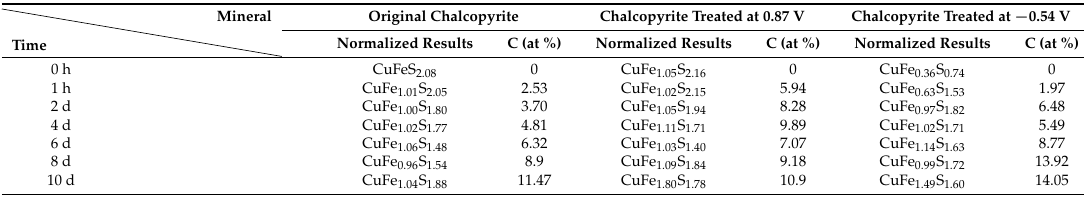
Table 2. The normalized EDS results of Cu, Fe, and S and atom percent (at %) of elemental carbon (C) for different chalcopyrite surfaces at different leaching times on flat